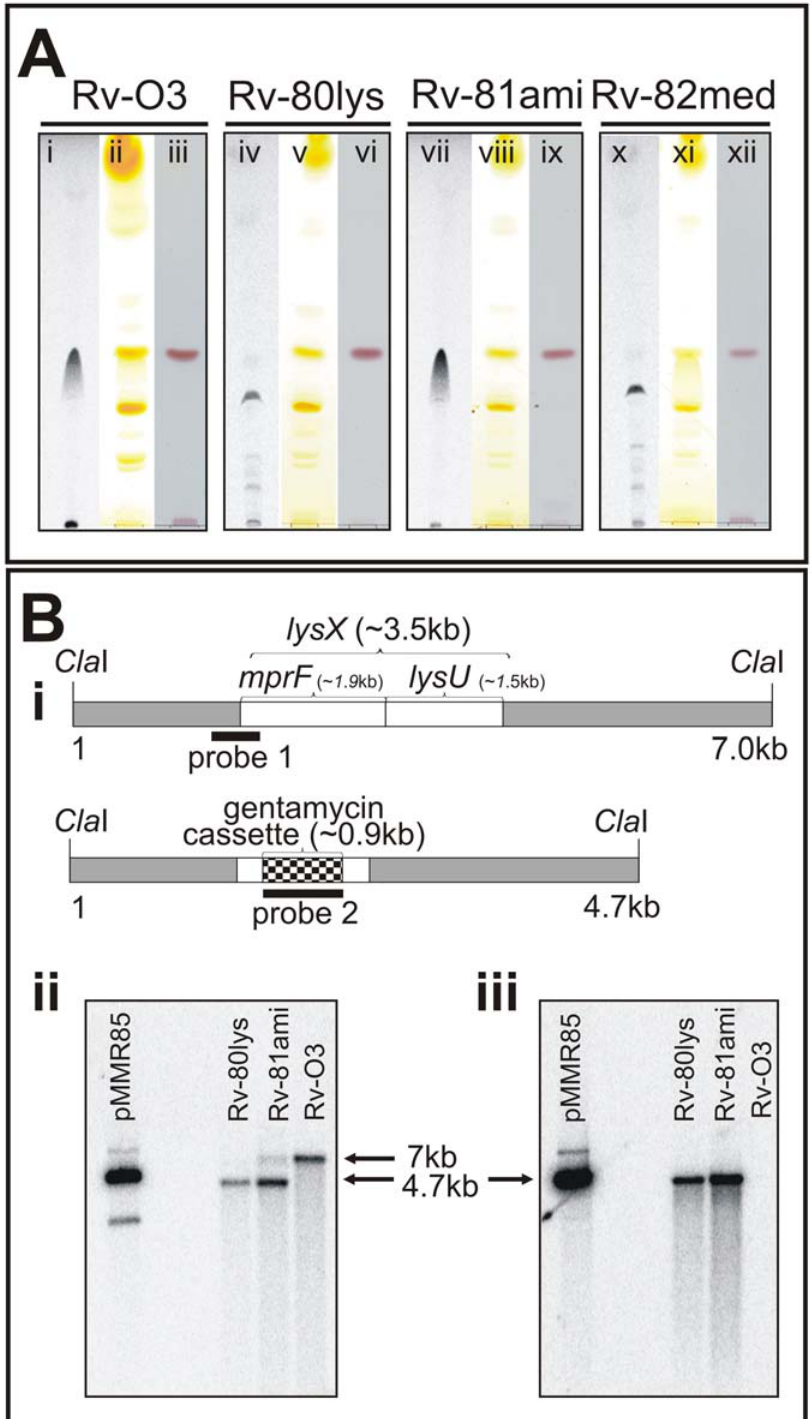
Figure 1. Polar lipid and Southern blot analysis of the lysX mutant strain. A: Mtb strains were grown in the presence and absence of 14 C- lysine. Total lipids were extracted in chloroform:methanol (2:1 v/v) and resolved by TLC on Silcia Gel 60 (EMD Chemicals, New Jersey) in a solvent system of chloroform:methanol:water (65:25:4 v/v/v). TLC plates were either visualized by autoradiography (lanes i , iv , vii and x ), exposed to iodine vapors (lanes ii , v , viii and xi ), or stained with ninhydrin (lanes iii , vi , ix and xii ). B: Southern blot analysis of Mtb lysX mutant strains. B-i: The Cla I fragment bearing the wild type lysX gene (3.5 kb) with the locations of the mprF and lysU regions marked. The dark box designated as ‘‘probe 1’’ is an approximately 750 bp fragment that hybridizes with the 5 9 -end of lysX and 160 bp of the lysX coding region. The Cla I fragment bearing the mutant lysX gene disrupted with the gentamycin cassette (0.9 kb) is also shown. The dark band designated as ‘‘probe 2’’ is the 900 bp gentamycin gene that hybridizes with the mutant lysX gene. B-ii: Southern blot analysis of Cla I-digested Mtb genomic DNA hybridized with probe 1. The 7 kb and 4 kb band positions represent Rv-03 and Rv-80lys, respectively. Note that the complemented copy contains a band corresponding to the integrated copy of lysX gene plus the flanking plasmid sequence. B-iii: Southern blot analysis of Cla I-digested Mtb genomic DNA (see Fig. 1B-iii) hybridized with probe 2. pMMR85 is a positive control plasmid containing the mutant lysX gene plus flanking regions.